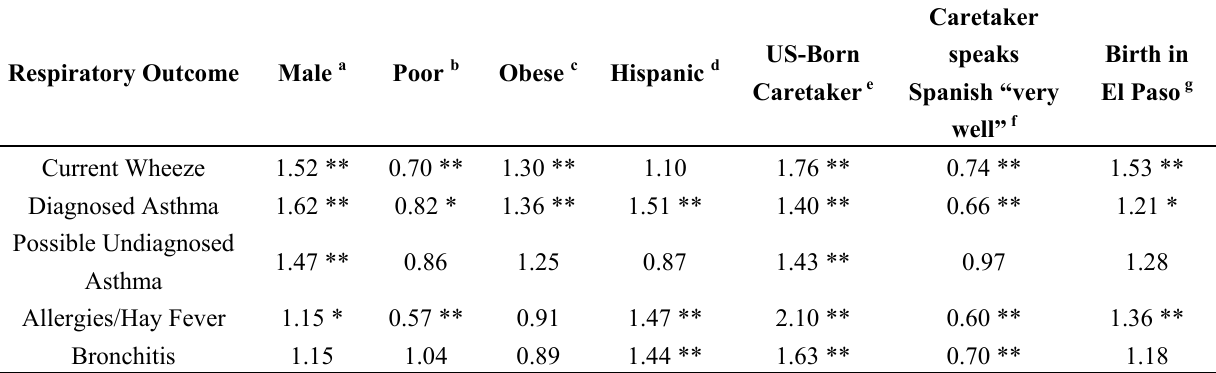
Table 4. Social disparities in respiratory health outcomes for all children: odds ratios and statistical